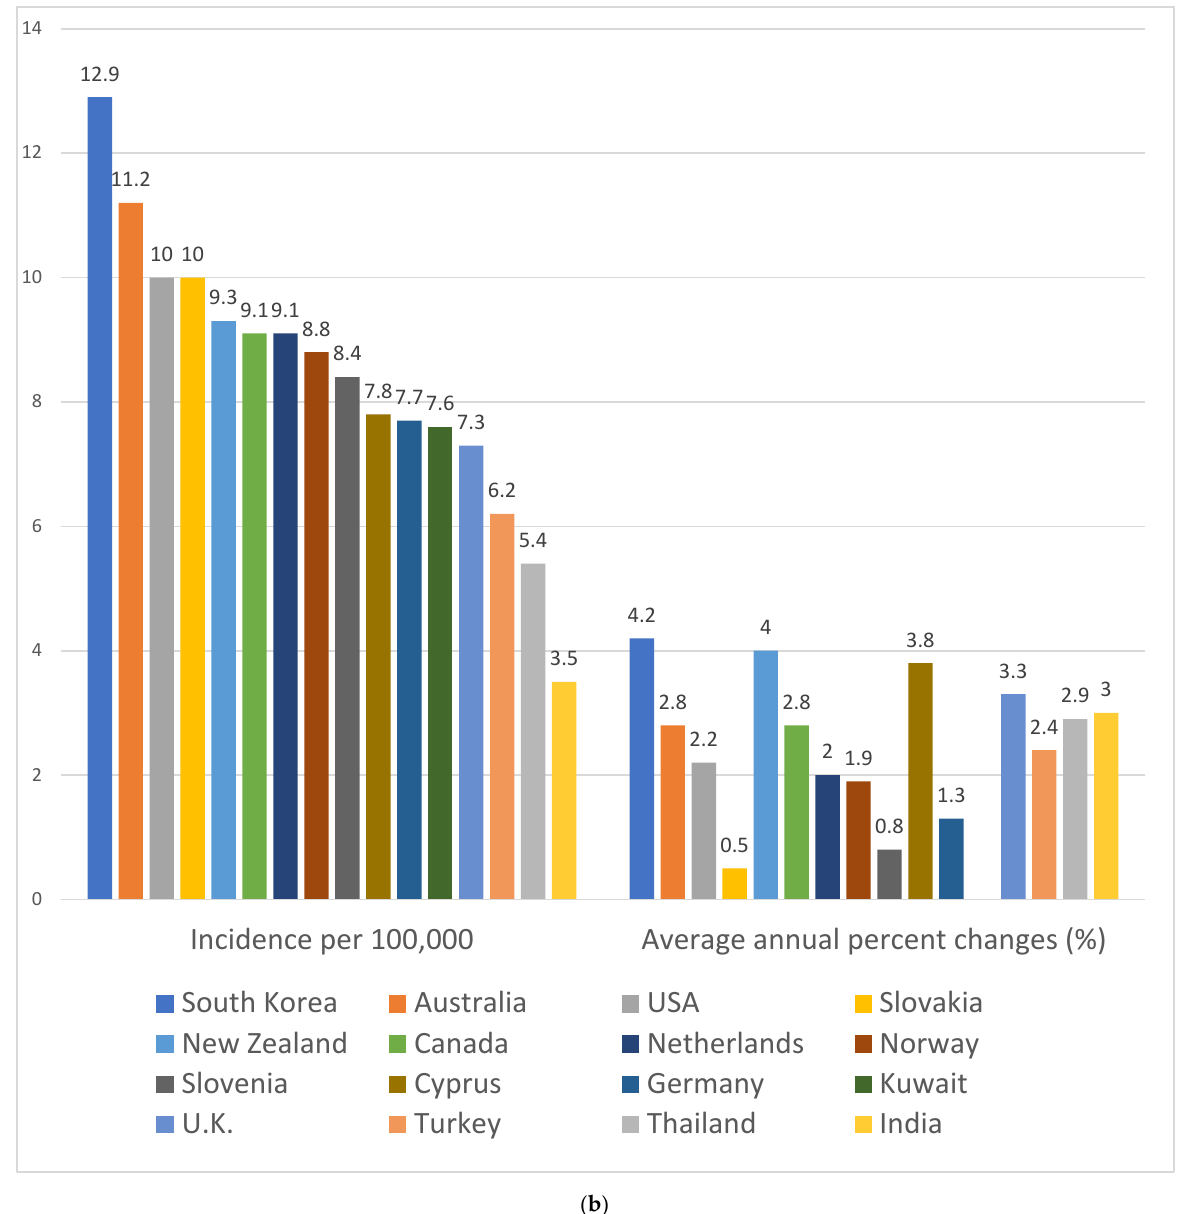
Figure 1. ( a ) . A recent trend in SEER Age ‐ adjusted colorectal cancer incidence rate from 2000 to 2019. Figure 1. ( a ). A recent trend in SEER Age-adjusted colorectal cancer incidence rate from 2000 to This figure was created by https://seer.cancer.gov/statistics ‐ network/explorer (accessed on 15 Feb ‐ 2019. This figure was created by https://seer.cancer.gov/statistics-network/explorer (accessed on ruary 2023). ( b ) Increase in early ‐ onset colorectal cancer incidence rate. This graph is created based 15 February 2023). ( b ) Increase in early-onset colorectal cancer incidence rate. This graph is created on the summary of the published articles by Siegel, R.L. et al. [9]. based on the summary of the published articles by Siegel, R.L. et al. [9]. The upward trend in the incidence of EOCRC started in the 1990s across the succes ‐ sive birth cohort of people born in and after the 1960s [9,17]. Based on CRC incidence Unmeasured exposures occurring in early life, or exposures frequently experienced by trends between 1975 and 2010 in the USA, the annual percent change ‐ based predicted younger generations in countries with very high HDI, may increase the risk of EOCRC and incidence rates of colon cancer in 2030 will increase by 27.7% for the age of 35 to 49 and can be represented as the birth cohort effect on EOCRC incidence [17]. Additionally, the 90% for the age of 20 to 34 [18]. The incidence rate of rectosigmoid and rectal cancer is rise of CRC for overall ages in countries with a swift shift of development status suggests predicted to be even higher—than that of colon cancer—46% for those aged 35 to 49 and that exposure to certain risk factors during a timeframe of life might have triggered the expression of CRC after a latent period [17]. The greatest fear is that predisposition to carcinogens early in life, from the prenatal to adolescence, might exert mutagenic damage during the developmental period, possibly resulting in a delayed effect on EOCRC incidence [21]. The cancer trend may portray a heavy disease burden in the future if urgent intervention is not initiated for the younger